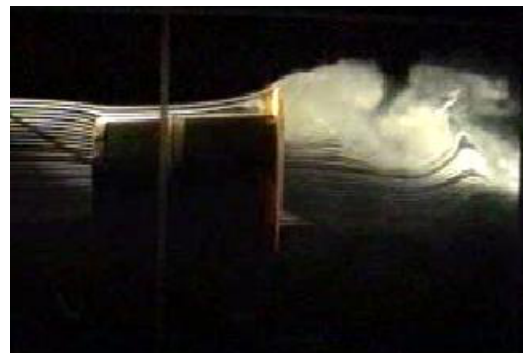
Figure 4. Flow around a circular-diffuser model with a brim. The smoke flows from left to right. L/D = 1.5. The area ratio μ (outlet area/inlet area) of the circular-diffuser model is 1.44. Karman vortices are formed behind